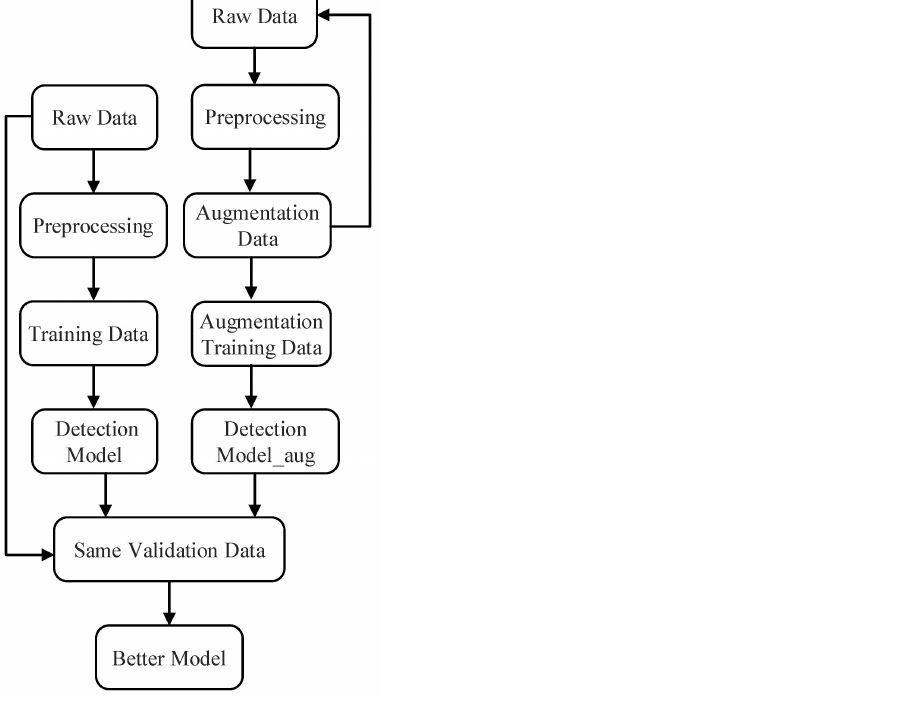
Figure 3. The flowchart for training and evaluating the supervised failure detection